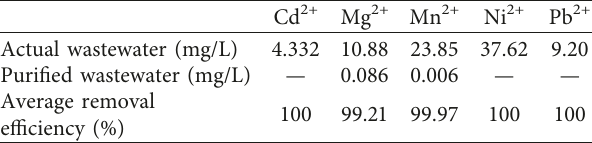
Table 4: Results of heavy metal ion